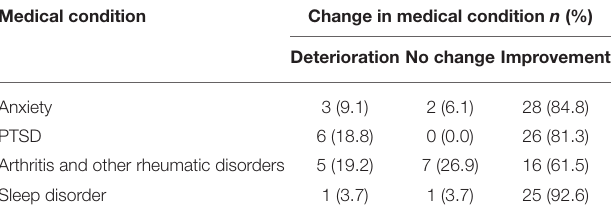
TABLE 6 | The number (and percentages) of the self-reported changes from patients with one of the top four medical conditions after 6 weeks of medical cannabis treatment.